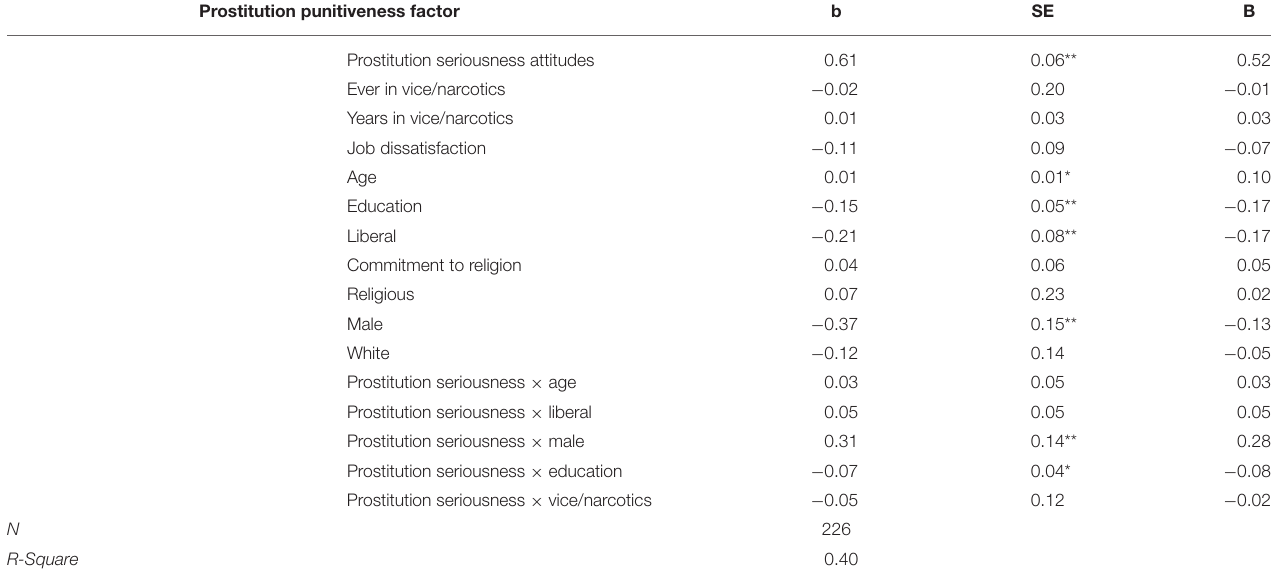
TABLE 6 | OLS regression estimating the relationship between prostitution seriousness attitudes and prostitution punitiveness attitudes. Prostitution punitiveness